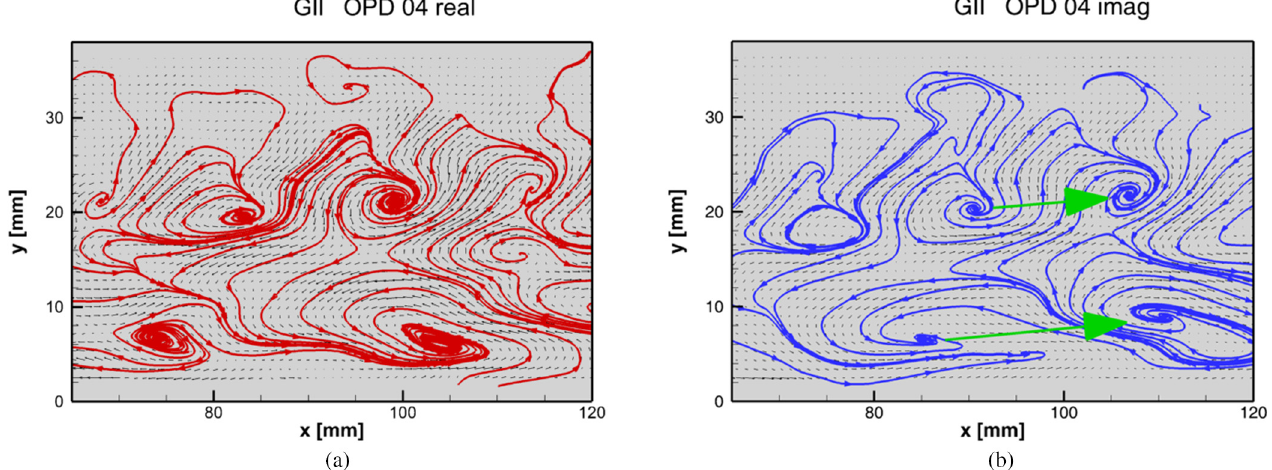
Fig. 19. Topology of the OPD mode no. 4 in the branch G, zone II, real (a) and imaginary (b) parts.